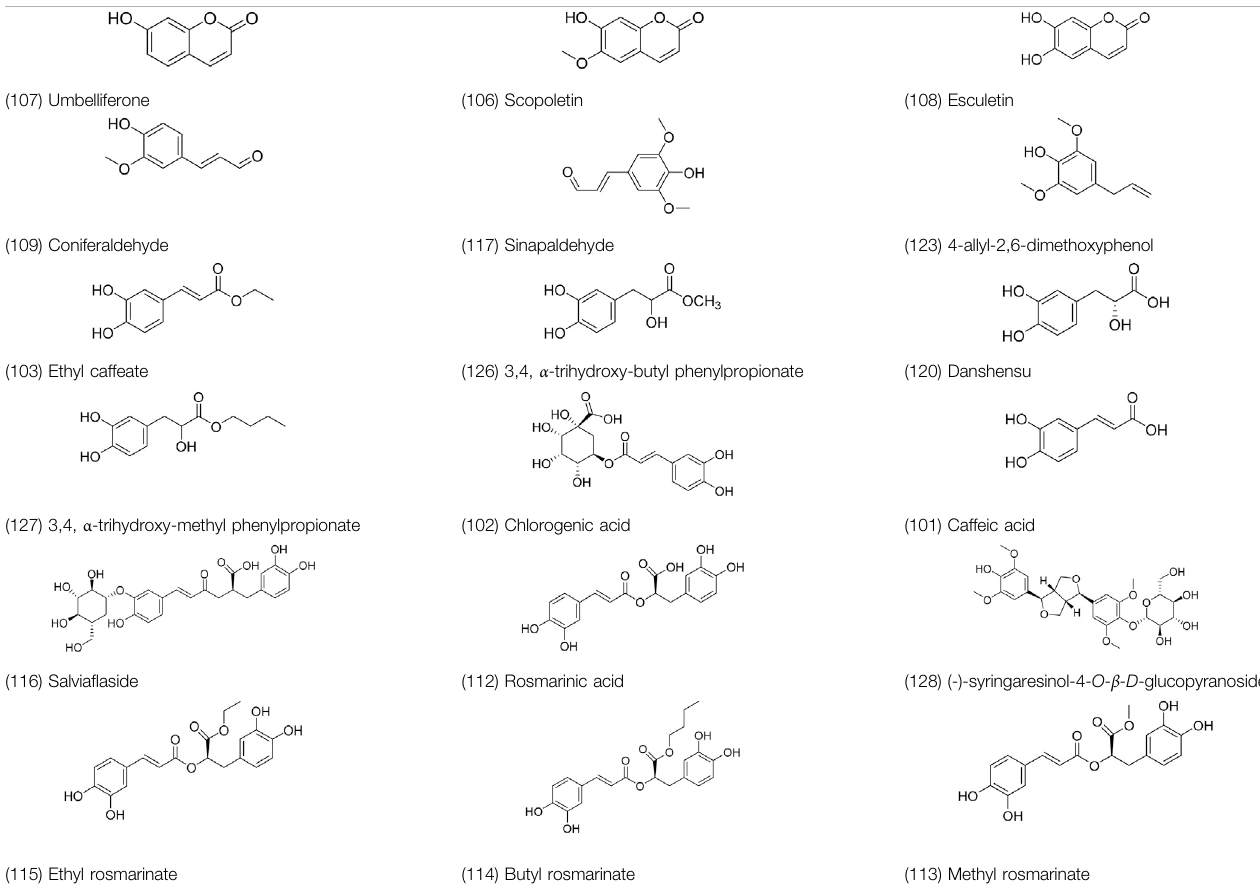
TABLE 9 | Chemical structures of phenylpropanoids isolated from